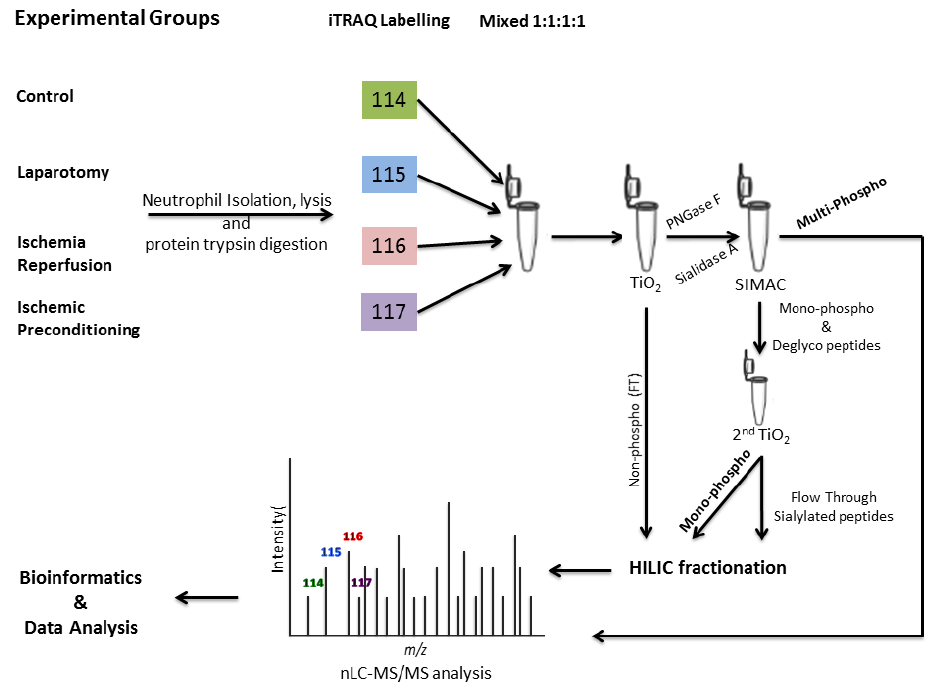
Figure 1. Schematic representation of the experimental workflow. Isolation of neutrophils by Ficoll density gradient from control (Ctrl), laparotomy (Lap), intestinal ischemia/reperfusion (iIR), and intestinal ischemic preconditioning (iIPC) groups followed by protein extraction and digestion. The iTRAQ labeling 114 for Ctrl, 115 for Lap, 116 for iIR, and 117 for iIPC was used. Mono- and multi-phosphopeptides enrichment was performed using TiSH (TiO 2 SIMAC HILIC fractionation). LTQ Orbitrap mass spectrometry (MS) analysis followed bioinformatics tools.